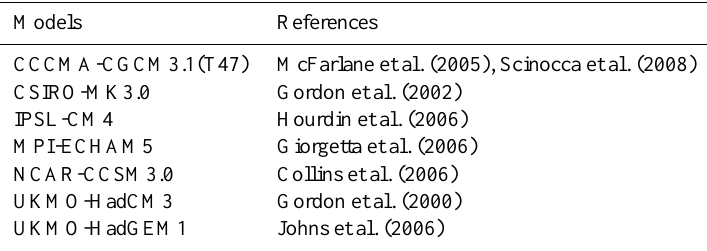
Table 2. Overview of GCMs used in this study.